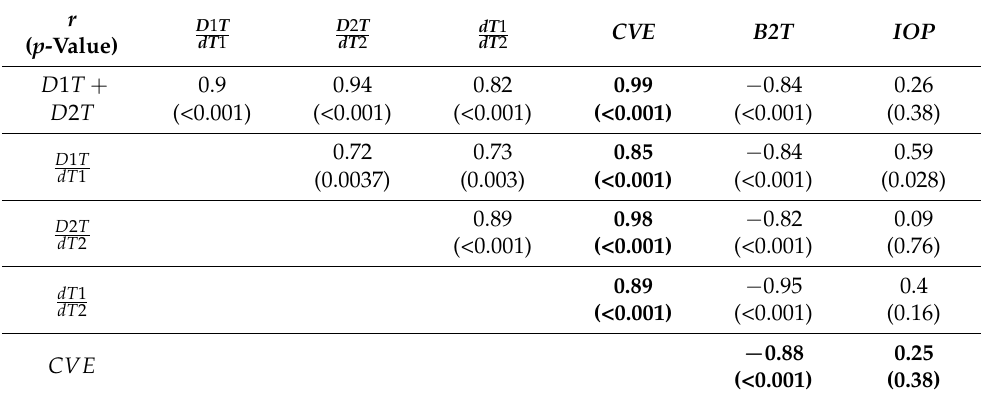
Table 3. Pearson’s correlation coefficients r with p -values (in parentheses) between selected parame- ters related to both buckling times and extremal profile slope velocities. Presented parameters have low or no correlation with IOP . They characterize the viscoelastic properties of the cornea.